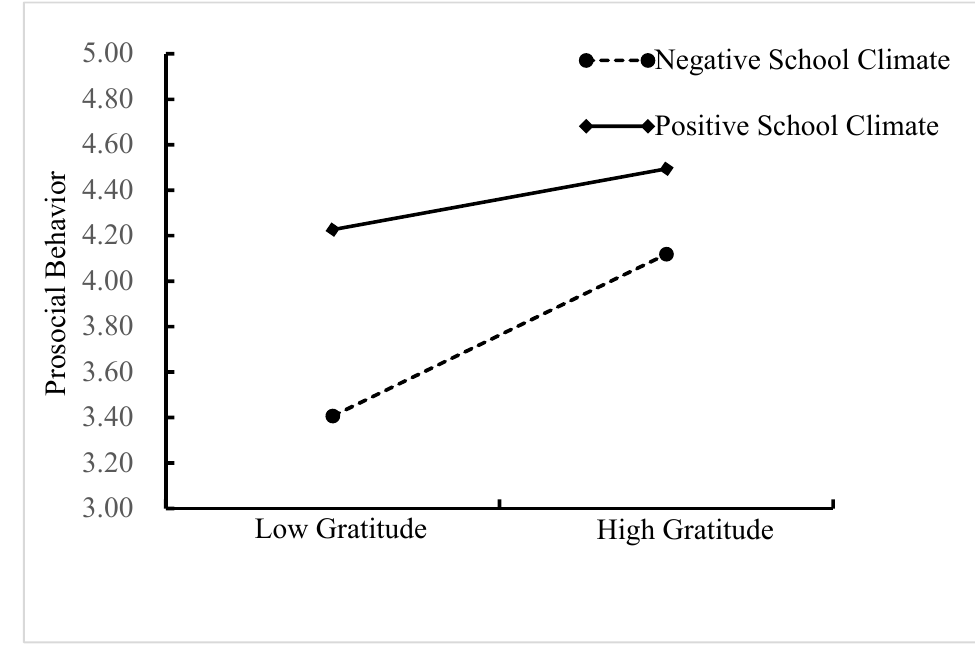
Figure 4. Gratitude among adolescents as a function of prosocial behavior and school climate. Moreover, the indirect links between parental warmth and prosocial behavior via gratitude were stronger for adolescents with a negative school climate (indirect effect = 0.09, SE = 0.02, p < 0.001, 95% CI [0.05, 0.14]) than for adolescents with a positive school climate (indirect effect = 0.06, SE = 0.02, p < 0.01, 95% CI = [0.02,